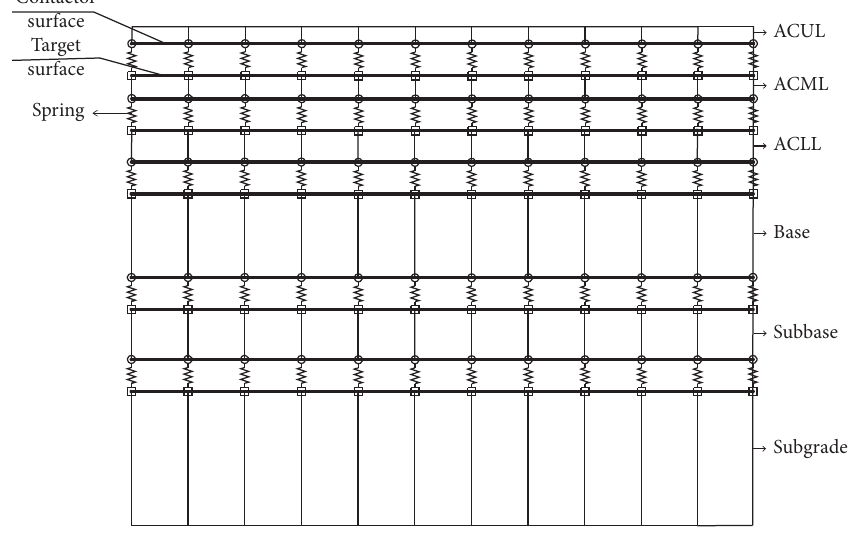
Figure 4: Schematic of the interlayer contact bonding